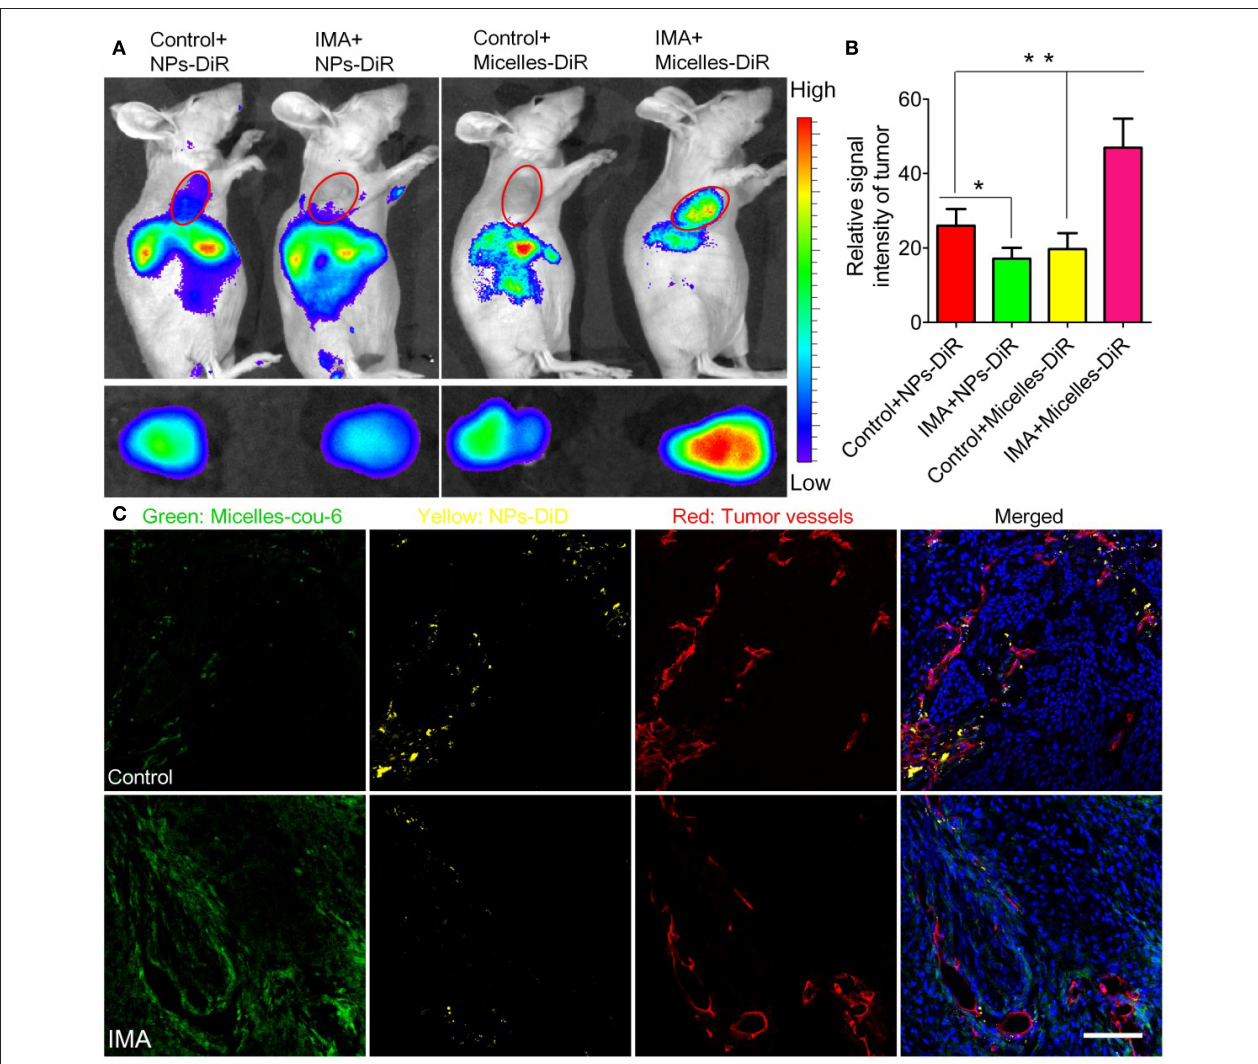
FIGURE 2 | The effects of IMA treatment on tumor nanoparticle delivery. (A) In vivo fluorescence imaging of A549 xenograft-bearing mice (the upper row) treated with IMA or water as a control, ex vivo fluorescence imaging of their corresponding tumor xenografts (the lower row), and (B) the relative signal intensity of tumor tissue 24h post the injection of DiR-labeled nanoparticles or micelles. * p < 0.05, compared with Control + NP group. ** p < 0.01 compared with IMA + Micelles group. (C) In vivo distribution of micelles and nanoparticles in tumor slices from A549 tumor xenograft-bearing mouse models treated with IMA or water at 24h after i.v. injection of a mixture of DiD-labeled nanoparticles and coumarin-6-labeled micelles. The oral dose of IMA was 50 mg/kg/d for 3 weeks. The dose of both coumarin-6 and DiD was 0.05 mg/kg. The bar indicated 100 µ m. Reprinted from reference with permission by copyright holder, Zhiqing Pang.